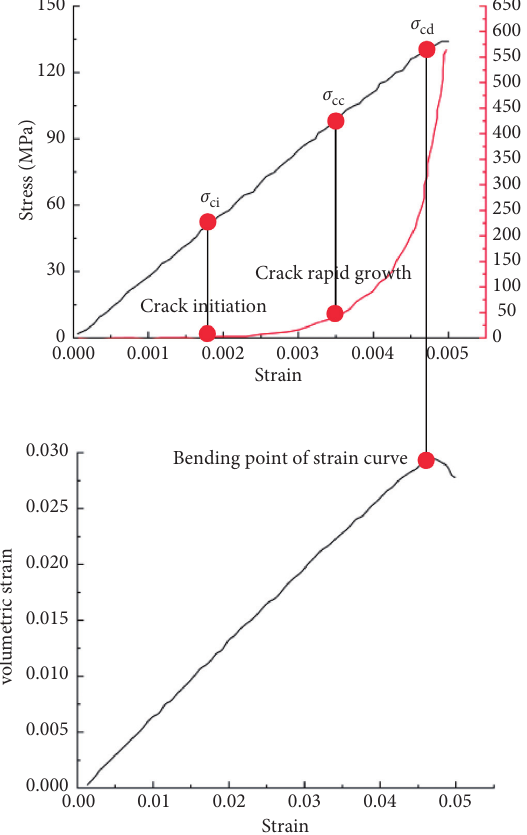
Figure 6: Cracks and volumetric strain in intact